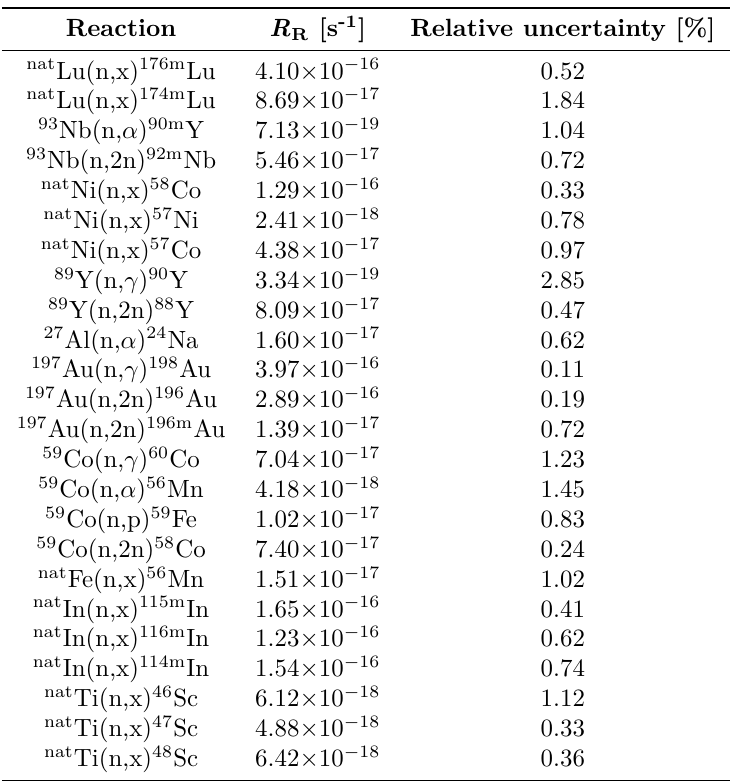
Table 3. The set of reaction rates and their uncertainties for observed reactions.